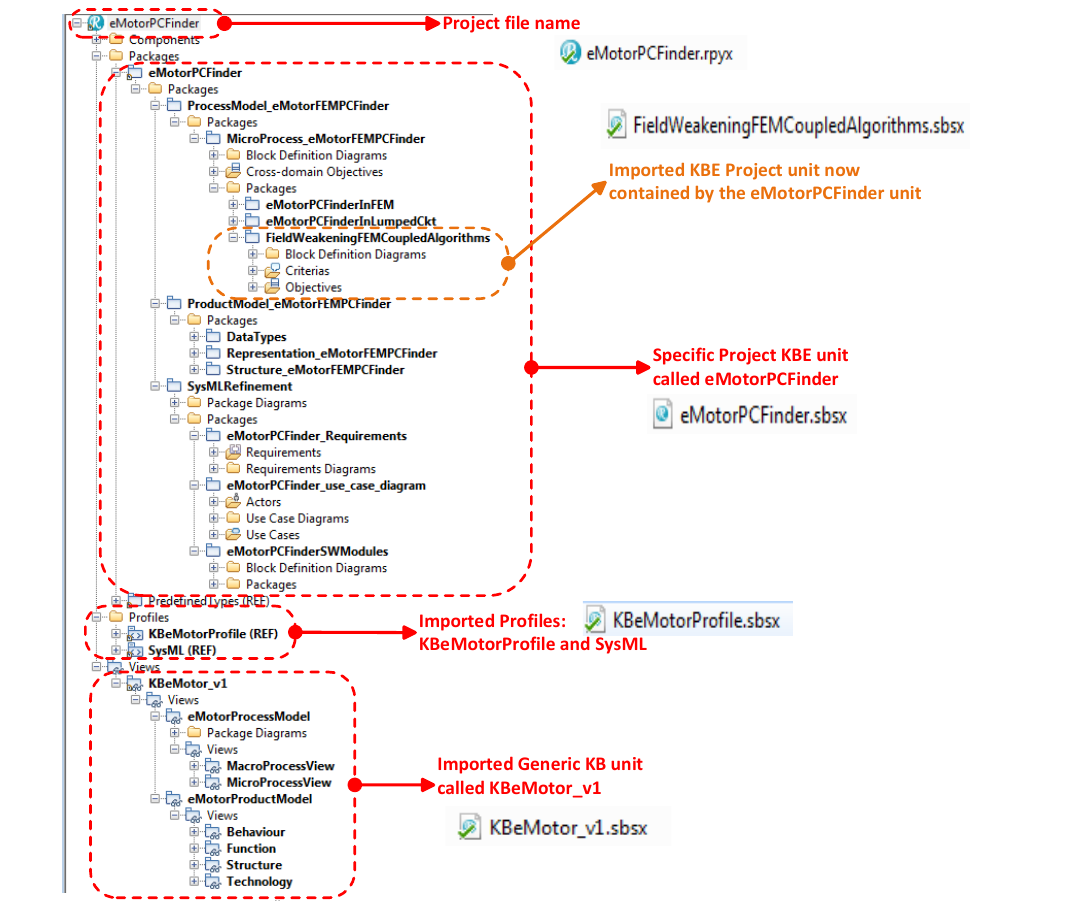
Figure 9. ( a ) Organization of folders with knowledge base (KB) units and profiles. ( b ) Example in a repository.